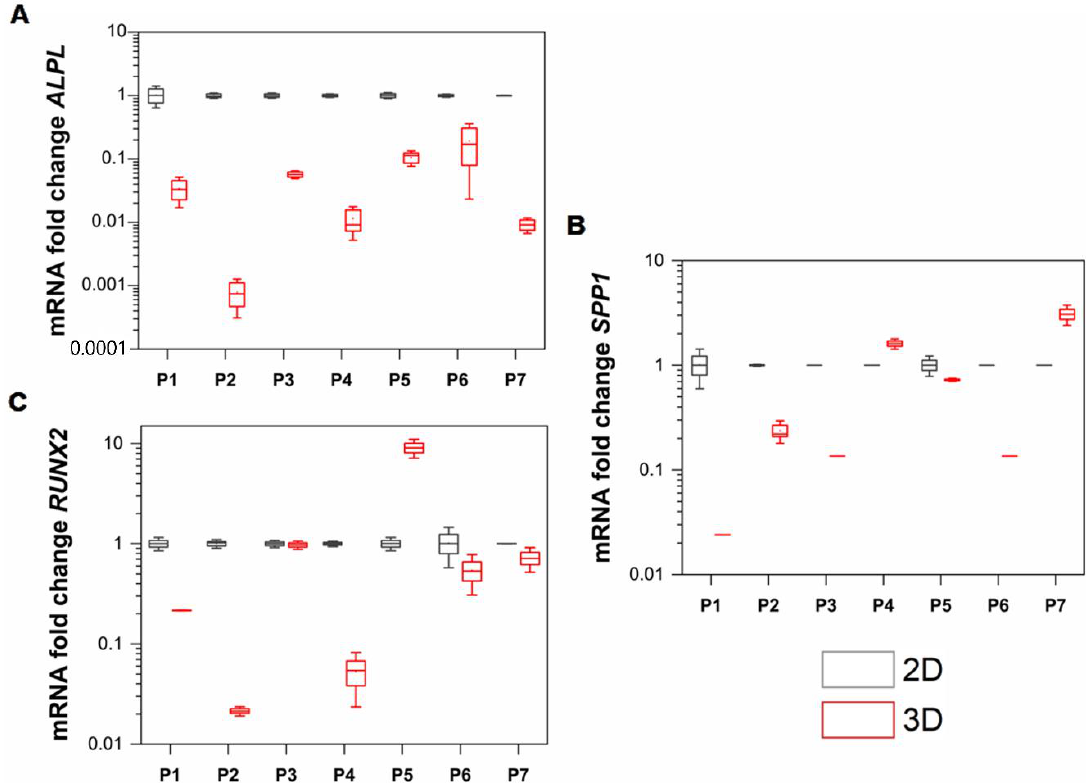
Figure 6. ( A ) ALPL expression ( p < 0.001). ( B ) RUNX2 expression ( p > 0.05). ( C ) SPP1 expression ( p >